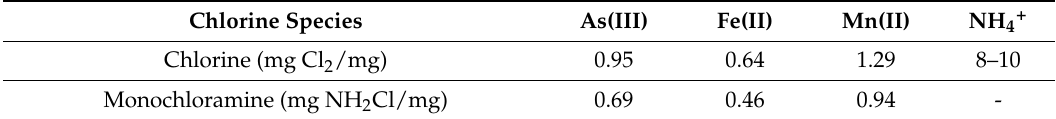
Table 2. Chemical oxidant stoichiometry